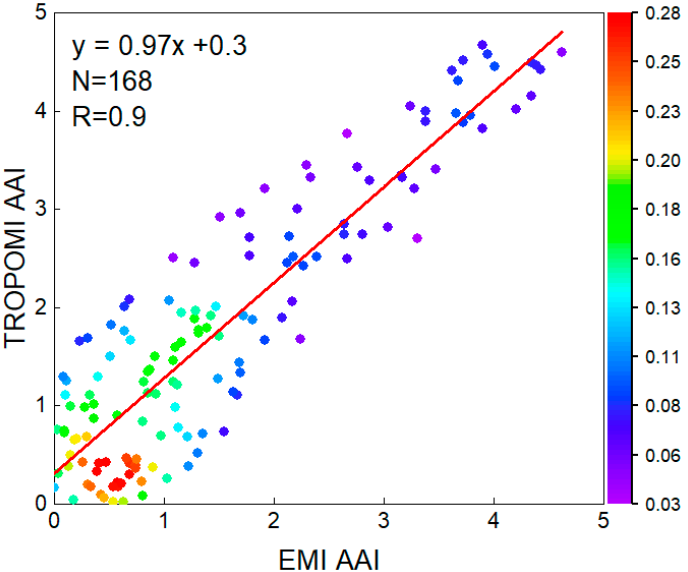
Figure 7. AAI comparisons between TROPOMI and EMI over the Sahara region on 6 August 2019.